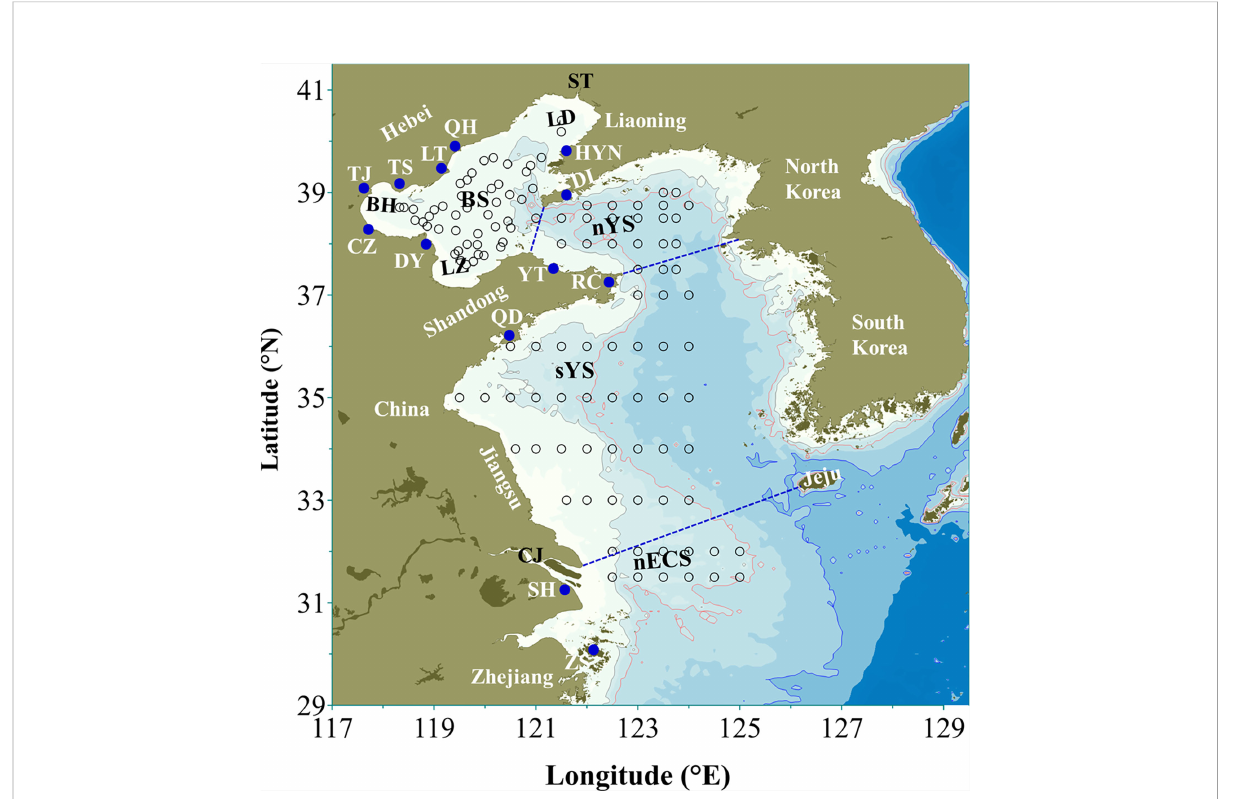
FIGURE 1 Map of Bohai, Yellow, and northern East China seas. BS: Bohai Sea, nYS: northern Yellow Sea, sYS: southern Yellow Sea, nECS: northern East China Sea, LD: Liaodong Bay, BH: Bohai Bay, LZ: Laizhou Bay, ST: Shuang Taizi River, CJ: Changjiang River, QH: Qin Huangdao, HYN: Hong Yanhe nuclear power plant, LT: Laoting, TS: Tangshan, DL: Dalian, TJ: Tianjin, CZ: Cangzhou, DY: Dongying, YT: Yantai, RC: Rongcheng, QD: Qingdao, SH: Shanghai, ZS: Zhoushan. The blue dots represented the locations of some coastal cities in China mentioned in the study. The black circles denoted the investigation stations of large jelly fi sh in Bohai, Yellow and northern East China seas in recent years cited from Zhang et al., 2012; Sun et al., 2015 and Wang et al.,